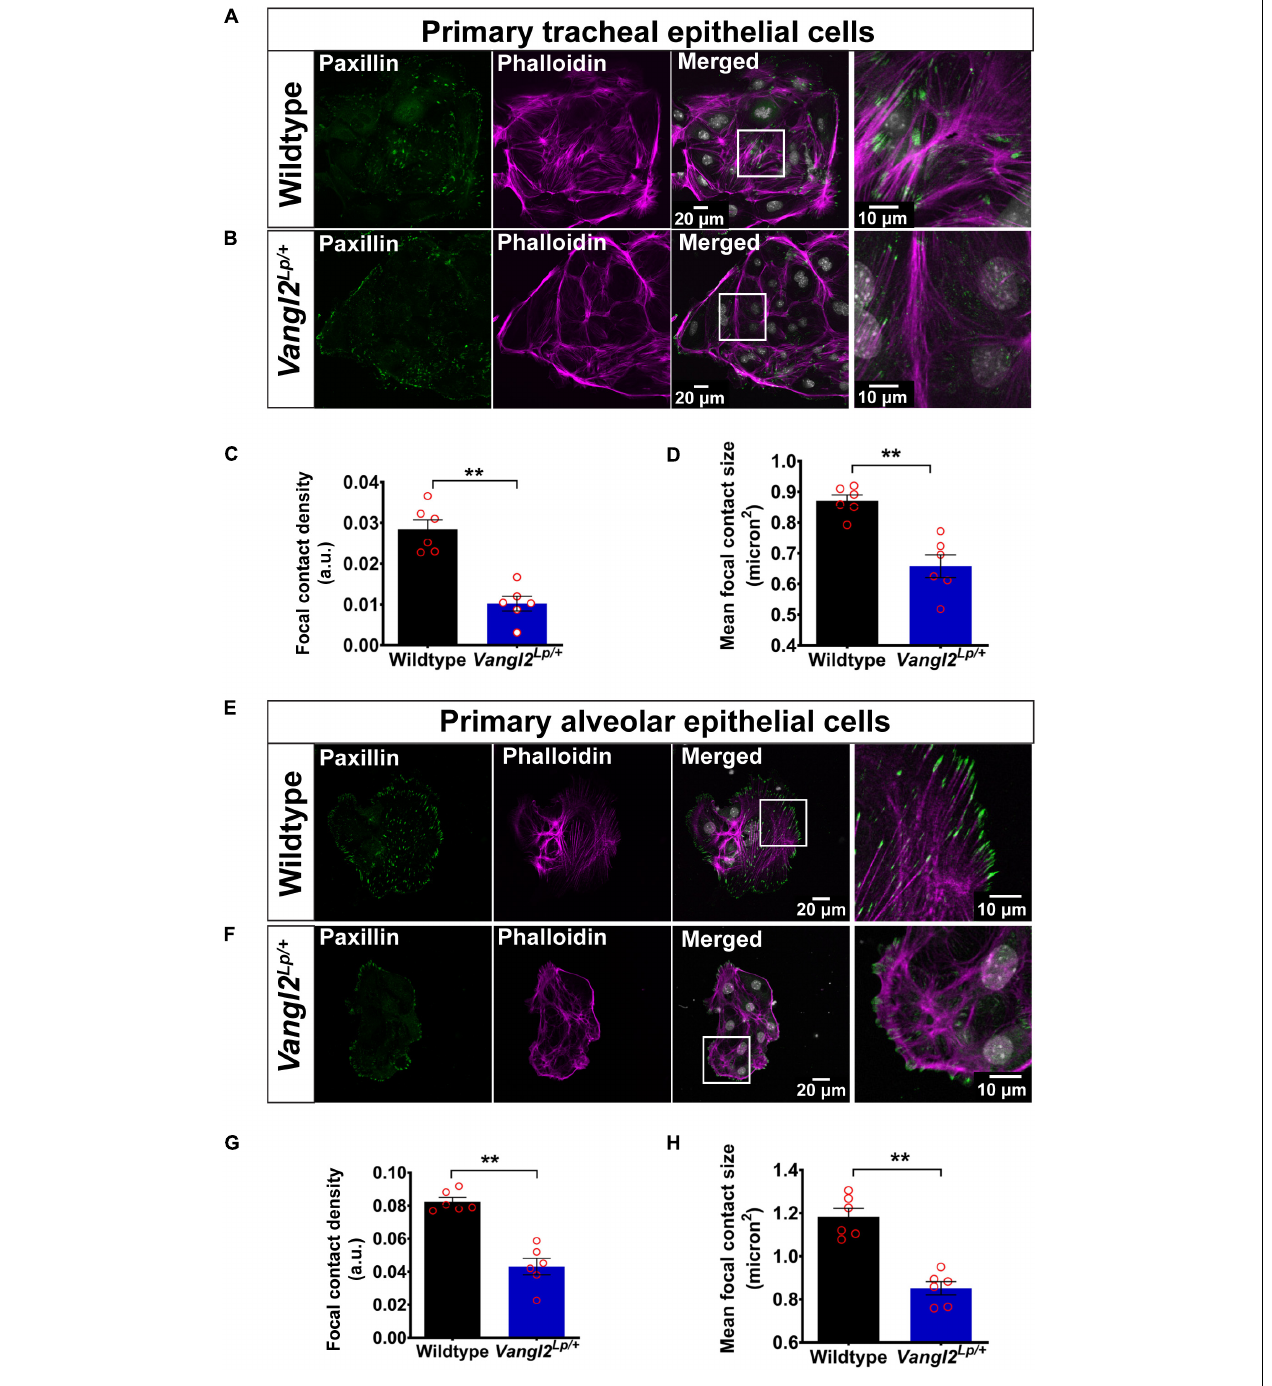
FIGURE 3 | VANGL2 dysfunction leads to highly disrupted actin cytoskeleton and focal adhesions. Representative images showing wildtype (A) and Vangl2 Lp / + (B) TECs labeled with phalloidin (magenta) to visualize F-actin and paxillin (green) to stain focal contacts. Nuclei were stained with DAPI (gray). Quantification of focal contact density (C) and mean focal contact size (micron 2 ) (D) in wildtype and Vangl2 Lp / + TECs. n = 3 independent experiments; TECs from three mice were pooled for each group per experiment; two technical replicates for each group per experiment; images from at least three fields were taken per technical replicate; each dot represents mean value per technical replicate. Mann–Whitney U -test, ** p < 0.01. Representative images showing wildtype (E) and Vangl2 Lp / + (F) AECs labeled with phalloidin (magenta) and paxillin (green). Nuclei were labeled with DAPI (gray). Quantification of focal contact density (G) and mean focal contact size (micron 2 ) (H) in wildtype and Vangl2 Lp / + AECs. n = 3 independent experiments; AECs from one mouse per group for each experiment; two technical replicates for each group per experiment; at least three fields were taken per technical replicate; each dot represents mean value per technical replicate. Mann–Whitney U -test, ** p < 0.01. All data are presented as mean ±